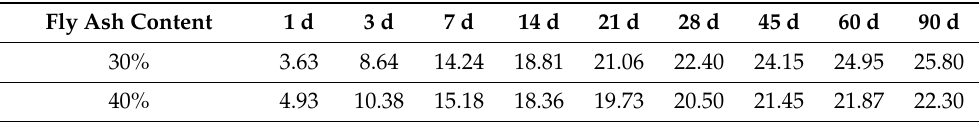
Table 2. Adiabatic temperature increases of oxygen magnesia concrete samples with varying water–binder